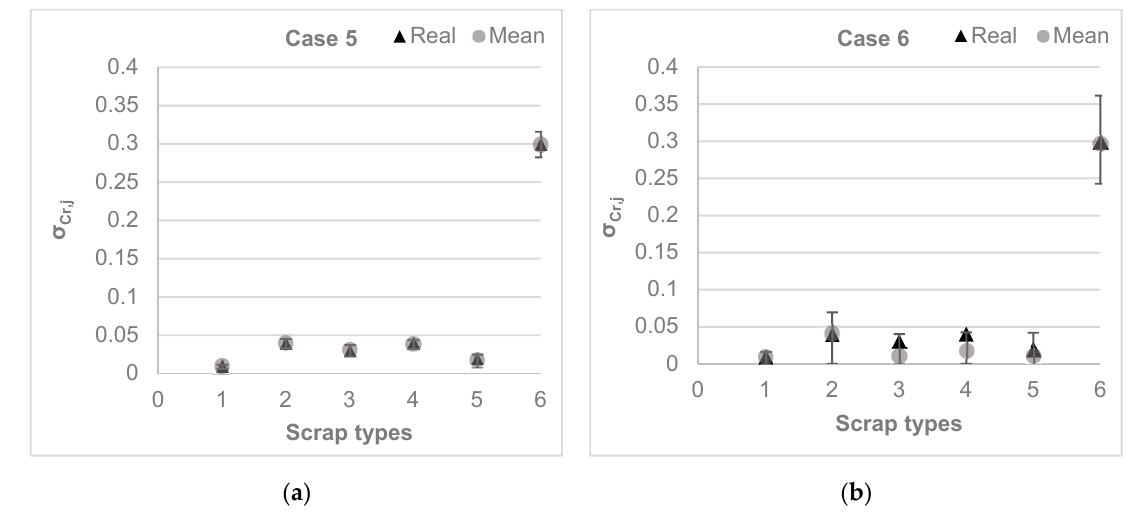
Figure 3. Estimated mean standard deviations for concentration of Cr ( σ Cr ) with a 95% confidence interval in six scrap types, x1–x6 for cases 5 and 6, ( a , b ).